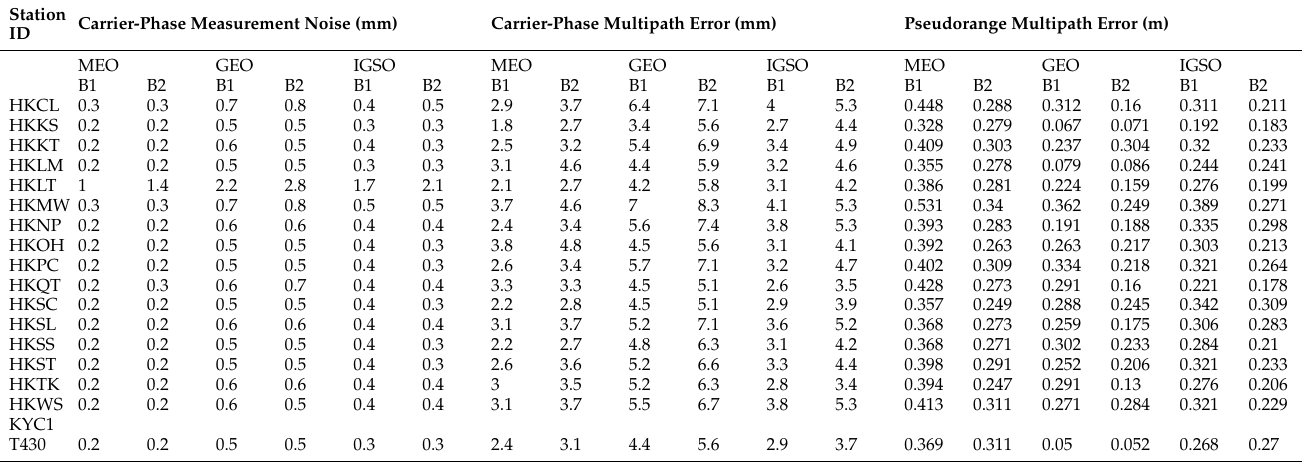
Table A4. Carrier-phase measurement noise, pseudorange, and carrier-phase multipath errors of the Hong Kong SatRef BDS B1 and B2 measurements at a 95% confidence